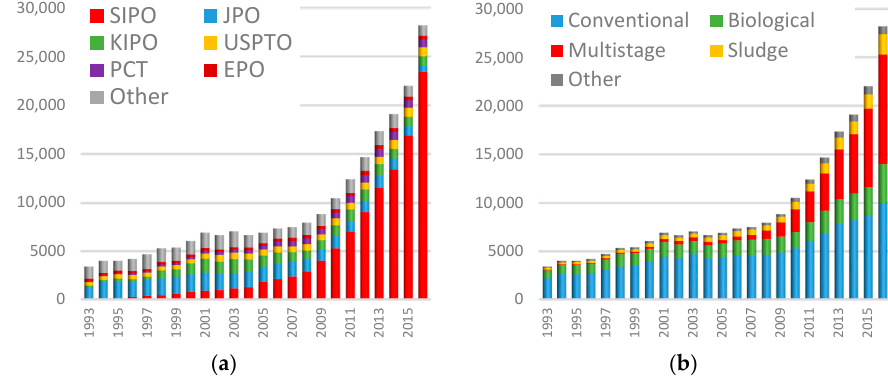
Figure 1. Trends in water treatment technology patents granted from 1993 to 2016 (number of patents).